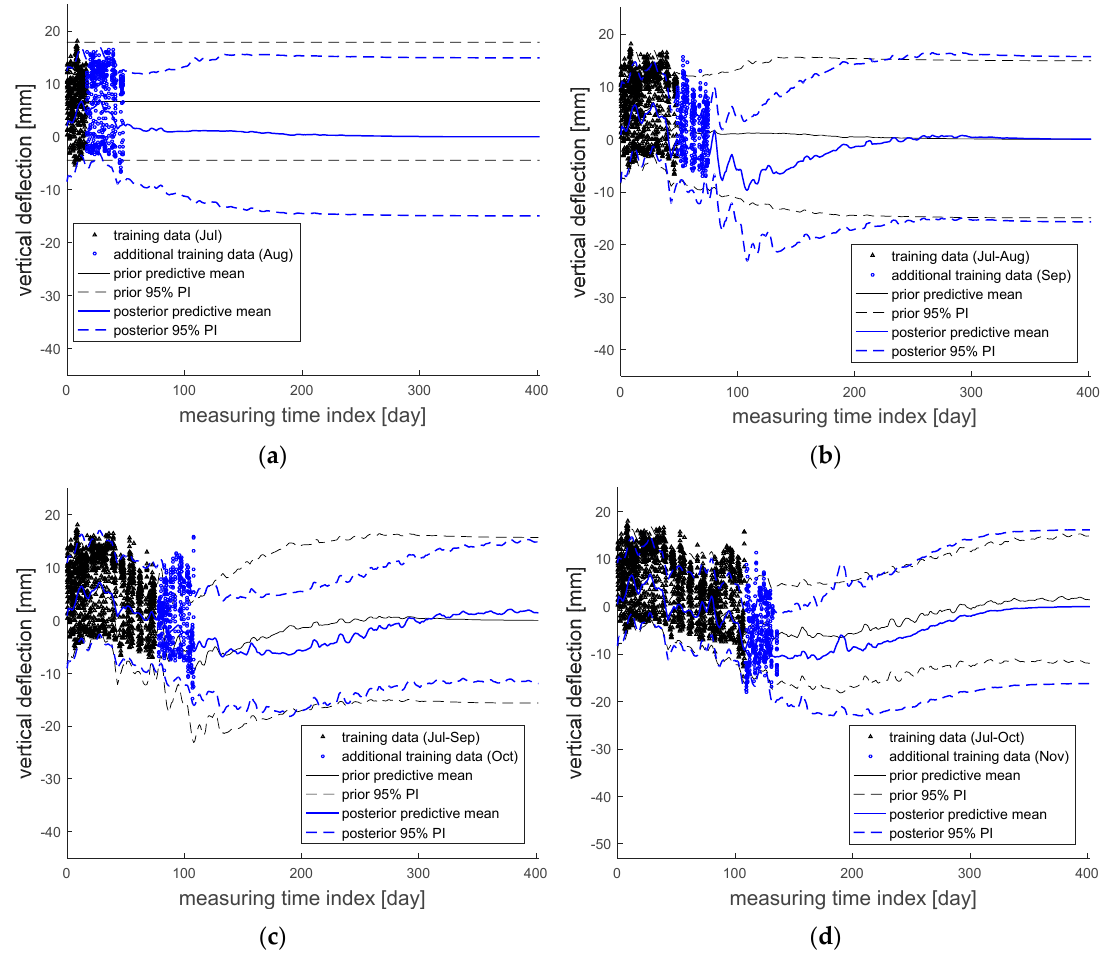
Figure 6. Sequentially updated predictive mean and 95% PI by adding the measurement data in: ( a ) August; ( b ) September; ( c ) October; and ( d ) November 2016.